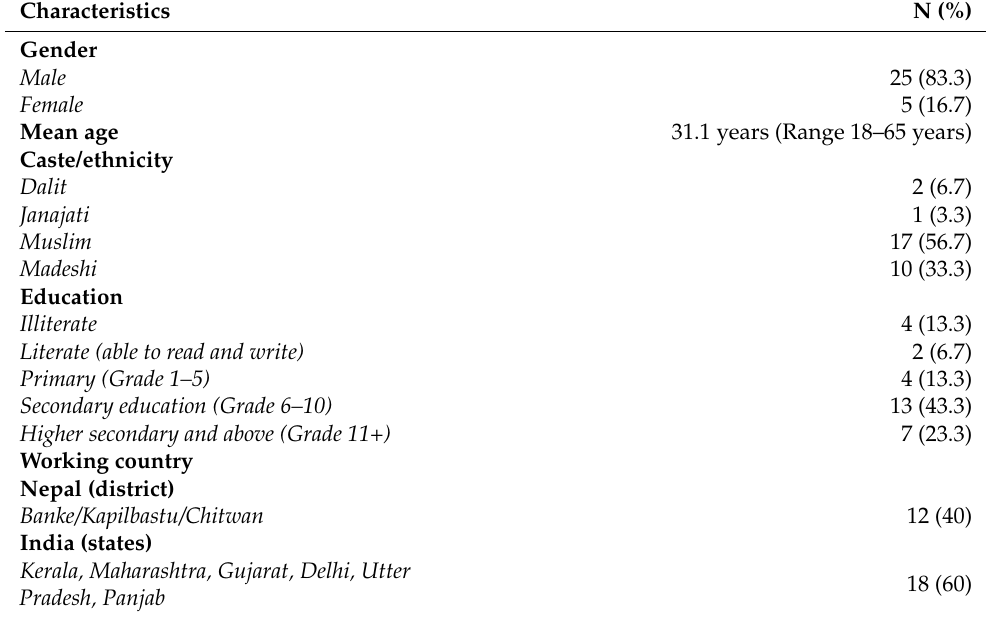
Table 1. Characteristics of the interview participants (N =